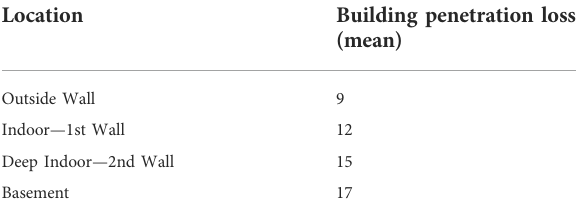
TABLE 4 Summarising both BPL and Probable